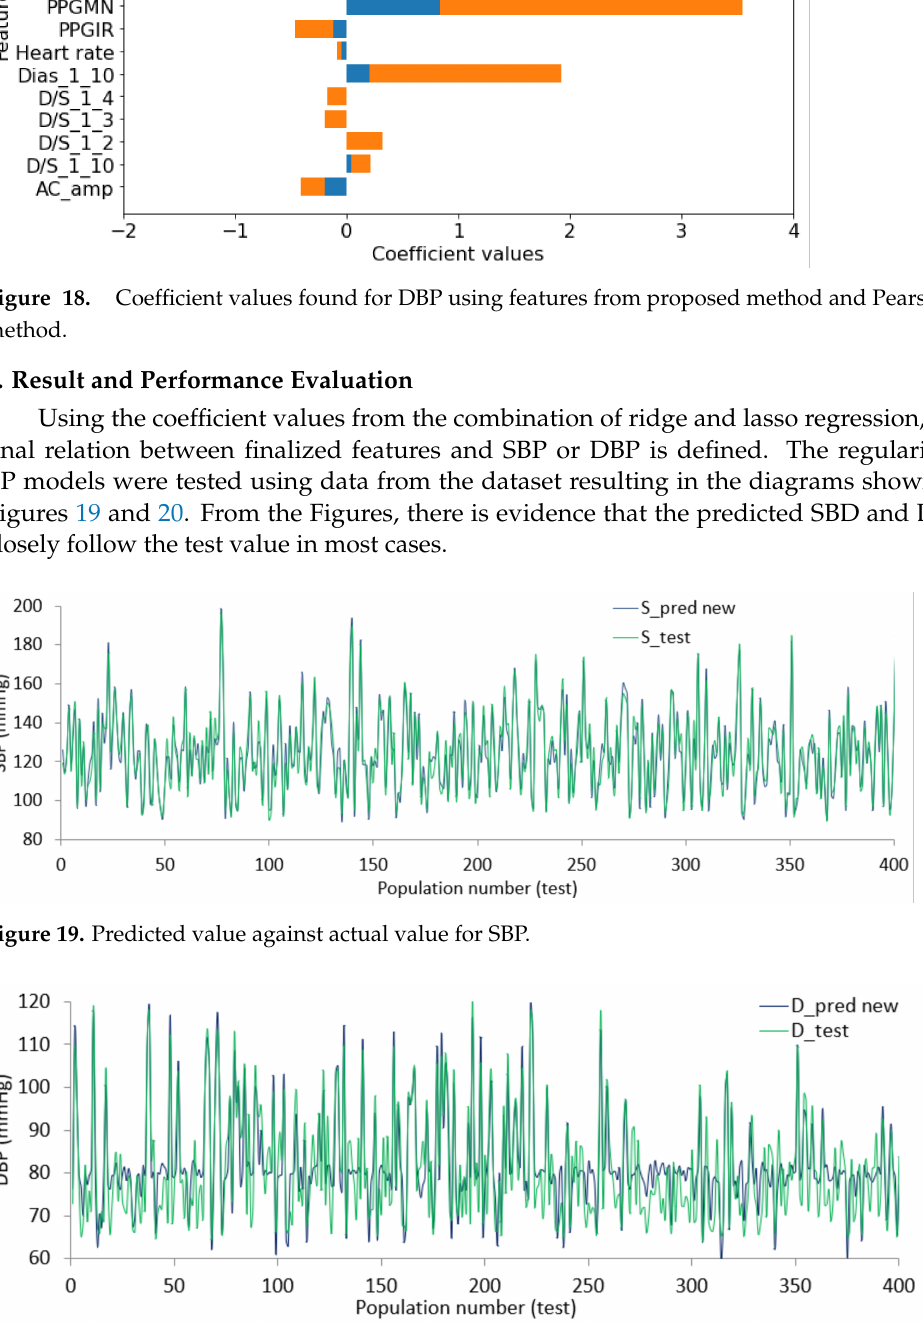
Figure 20. Predicted value against actual value for